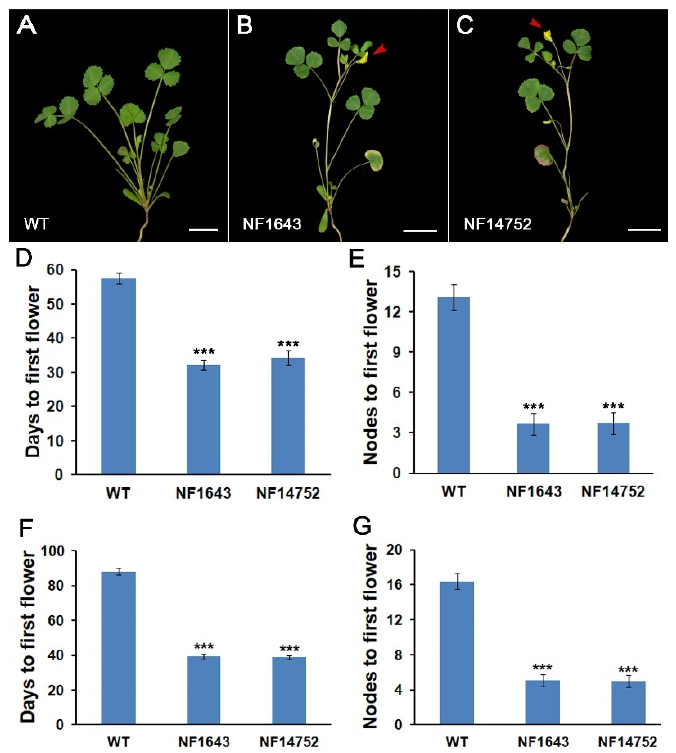
Figure 1. Early flowering phenotype in the mutant plants. ( A – C ) 5 ‐ week ‐ old plants of the wild ‐ type (WT) ( A ) and mutants ( B , C ) in LDs. Arrows indicate the flowers in the mutants. Bars = 1 cm. ( D ) The days to the first flower of WT and mutants in LDs. ( E ) Nodes to the first flower of WT and mutants in LDs. ( F ) Flowering time in days to the first flower of WT and mutant plants in SDs. ( G ) Nodes to the first flower of WT and mutant plants in SDs. The flowering time in ( D – G ) is shown as means ± SD ( n = 10). ***: means differ significantly ( p < 0.001).